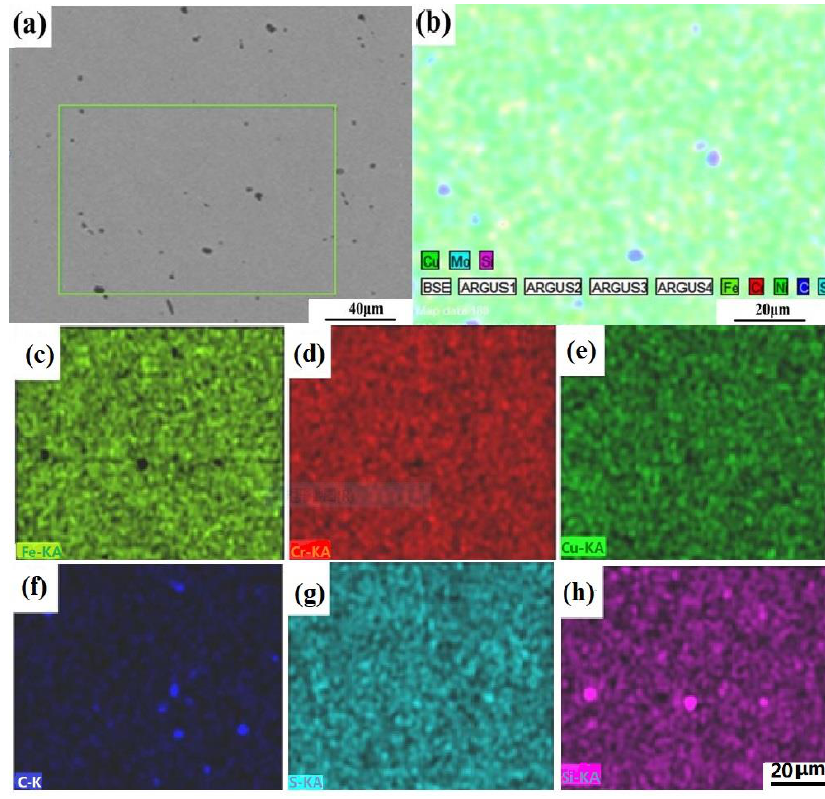
Figure 5. SEM image and EDS maps of elements with the strain of 0.2 at 1050 °C.